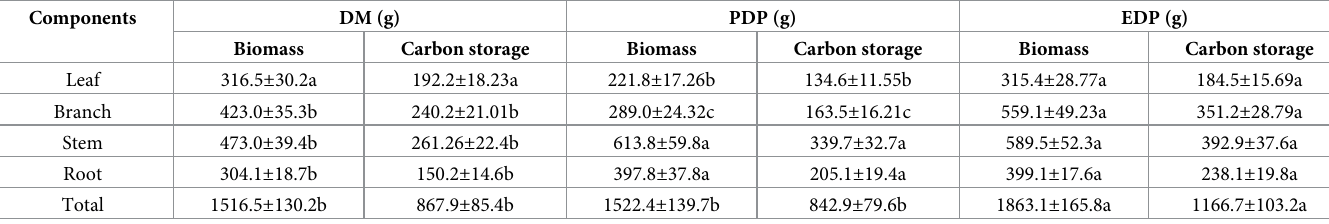
Table 3. Biomass and carbon storage of single plants of D . viscosa for different components in different vegetation types. Components